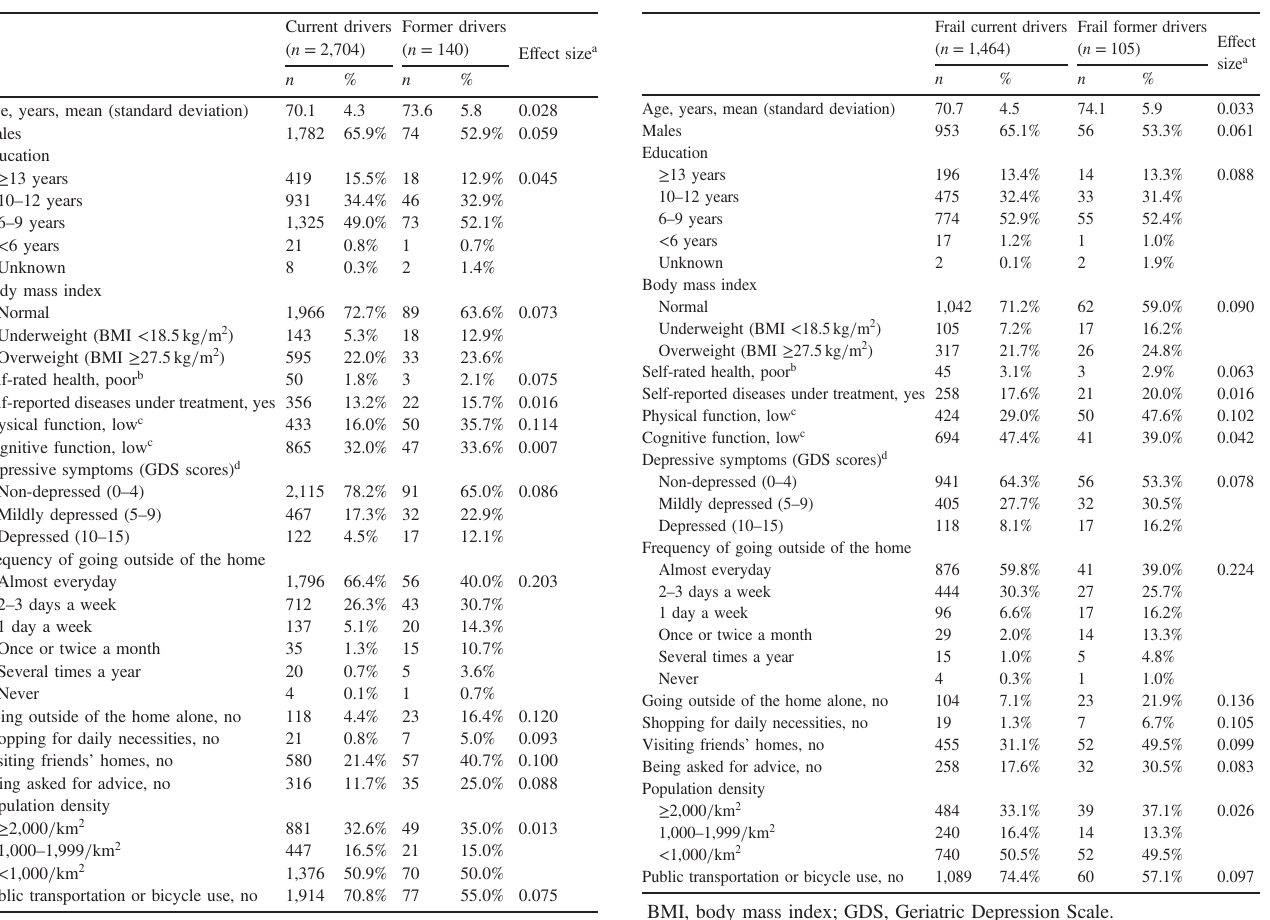
Table 2. The characteristics of frail current and former drivers,